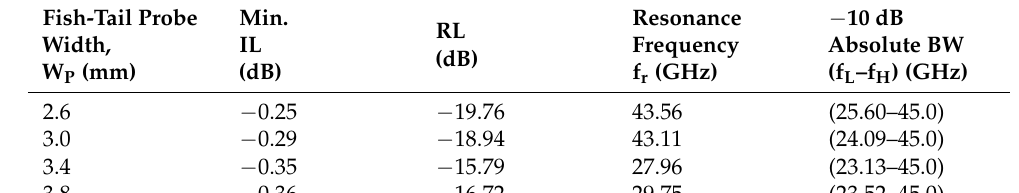
Table 5. Effect of fish-tail width variations with a fish-tail depth = 0.4 mm.